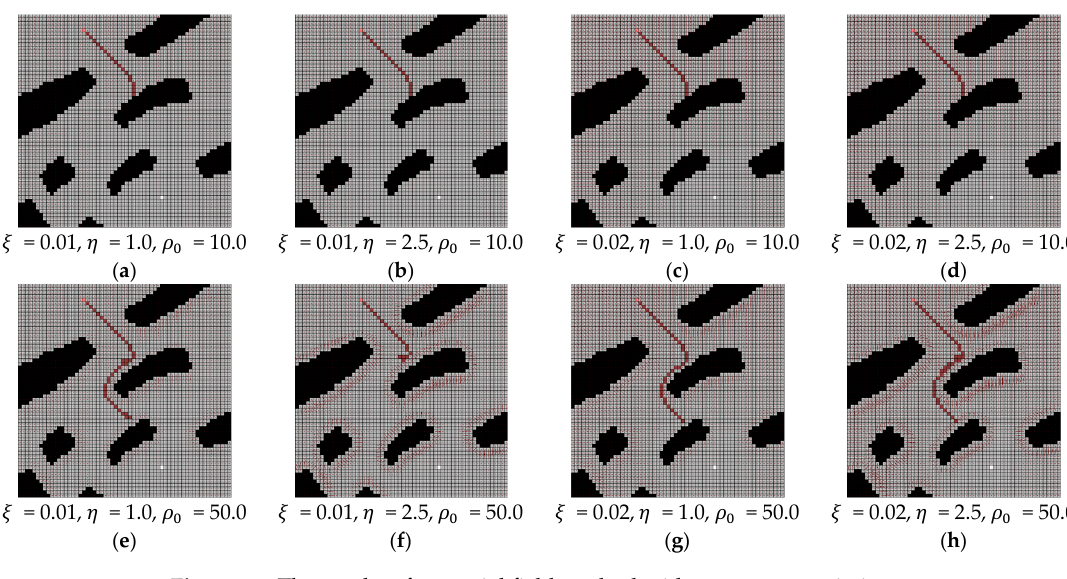
Figure 14. The results of potential field method with parameter variations. Table 1. The characteristics of parameters for potential field method.